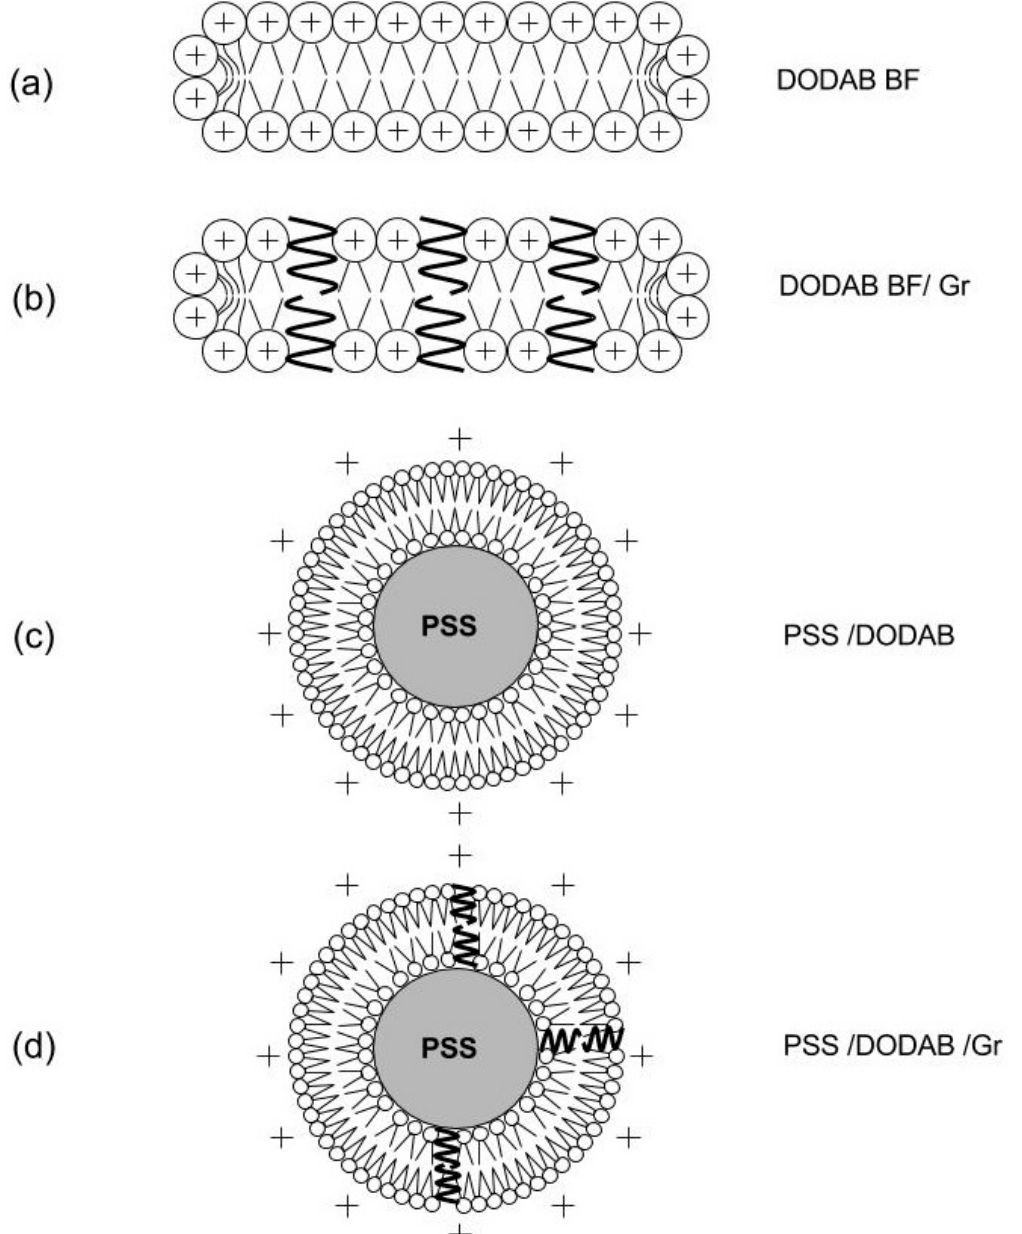
Figure 3. Some cationic BSA with two antimicrobials: the cationic lipid DODAB and the antimicrobial and neutral antimicrobial peptide Gr. ( a ) Bilayer fragments (BF) of the cationic lipid DODAB [26,39,52]; ( b ) BF incorporating dimeric channels of Gr [11,59]; ( c ) PSS NPs covered by a DODAB bilayer [12,65–67]; and ( d ) PSS NPs covered by a DODAB bilayer with inserted Gr dimeric channels [10]. Schematic representations are cross-sections. Reproduced from [10].